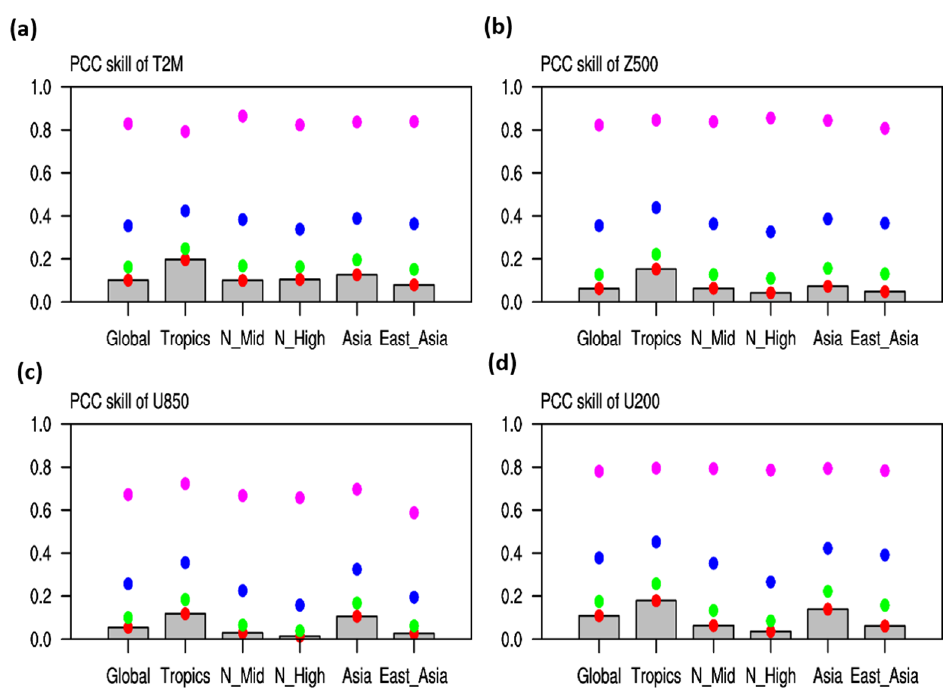
Figure 2. Averaged pattern correlation coefficient (PCC) for ( a ) surface temperature, ( b ) 500 hPa geopotential height, ( c ) 850 hPa zonal wind, and ( d ) 200 hPa zonal wind. Pink, blue, green, and red dots indicate lead times of 1, 2, 3, and 4 weeks, respectively. Grey bars also indicate a lead time of 4 weeks.